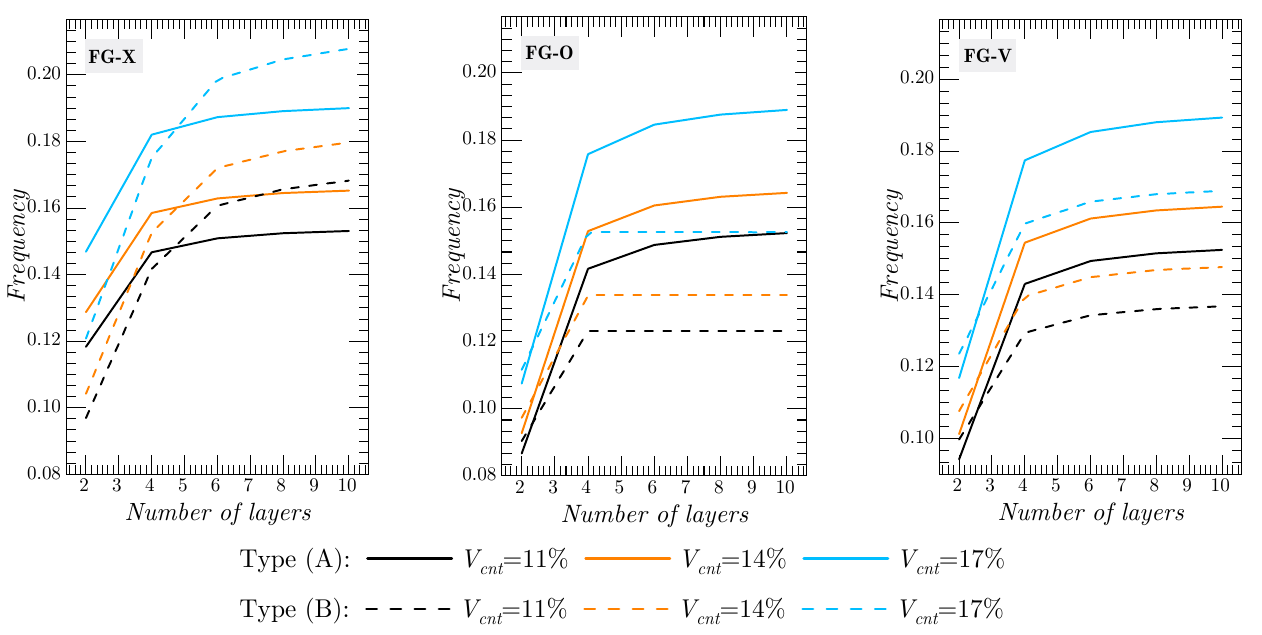
Figure 5. Effect of the number of layers N on dimensionless frequencies of various CNTRC plate types (𝑆𝑆𝑆𝑆,𝑝 = 1, 𝑇 = 300𝐾) .